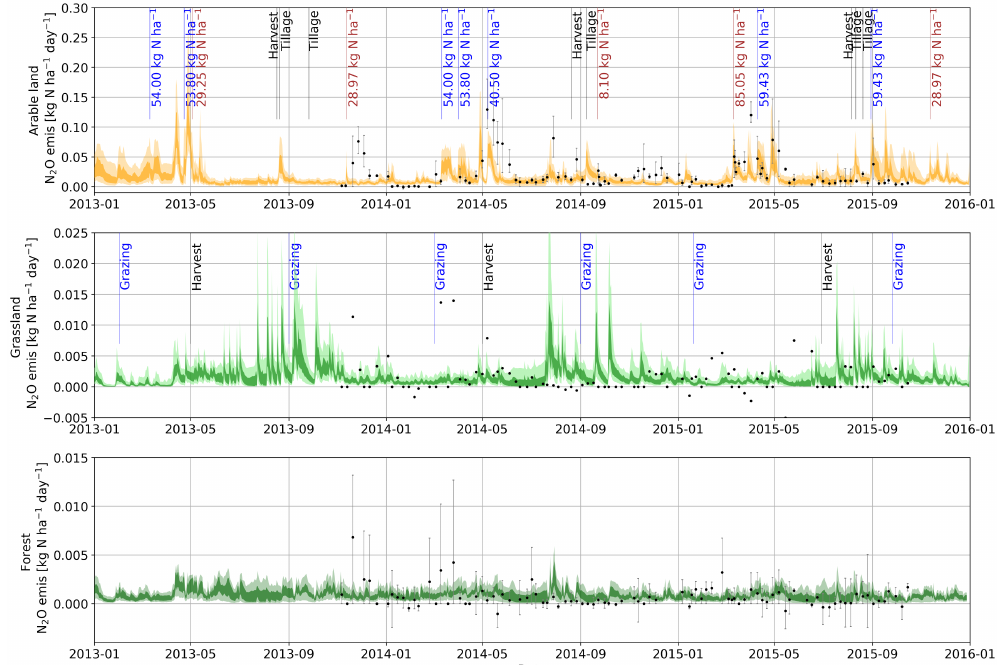
Figure 2. Measured and modelled N 2 O emissions from different land use. Measurements are given as grey error bars showing the variance between the replicated transects and the mean value as a black dot. Posterior model uncertainty is given in light colour for the 5th and 95th percentiles and dark colour for the 25th and 75th percentiles. Vertical lines indicate management events. In the uppermost panel, blue coloured vertical bars indicate fertilizer application, while brown colours indicate manure